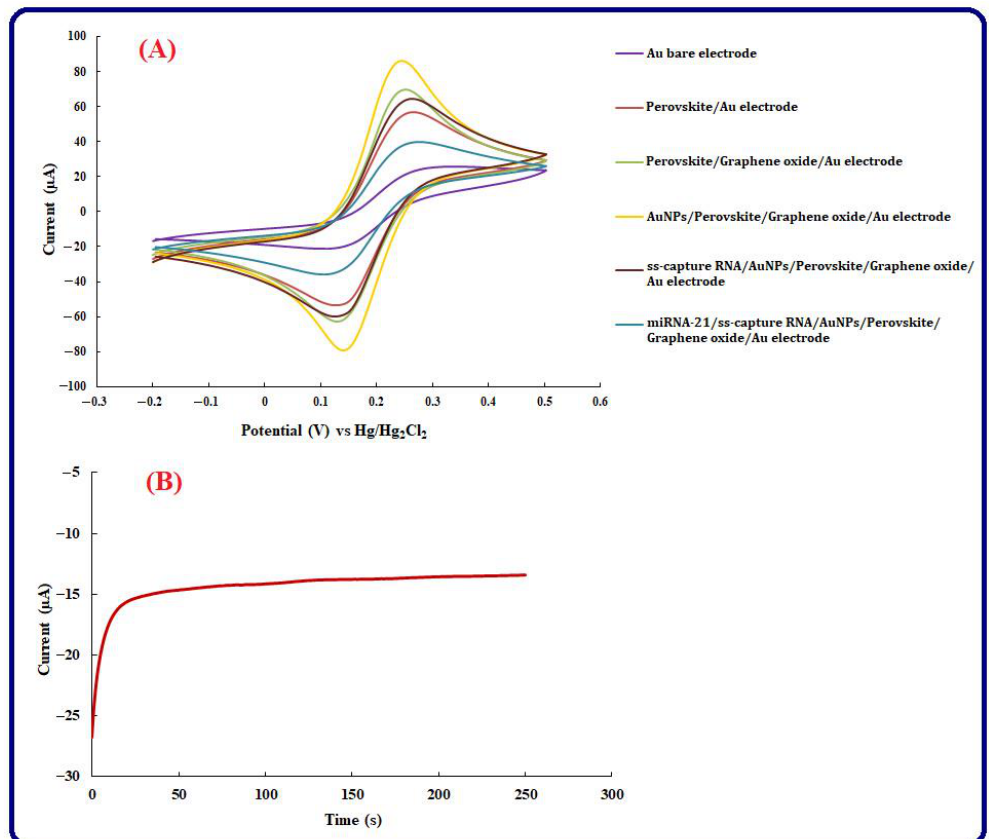
Figure 3. ( A ) CV voltammograms of Au bare electrode, Au modified electrode by Perovskite, Au modified electrode by Perovskite/graphene oxide, Au modified electrode by Perovskite/graphene oxide/AuNPs/ss-capture RNA, and Perovskite/graphene oxide/AuNPs/ss-capture RNA/miRNA-21 in [Fe(CN) 6 ] 3−/4− as a redox probe. Also, the scan rate is 50 mV s −1 , and the potential range is −0 .2 to +0.5 V, ( B ) Au electrode Chronoamprogram in the solution including 20 mL of 0.01 M HAuCl 4 for immobilizing of AuNPs at E = 0 V for 500 s.